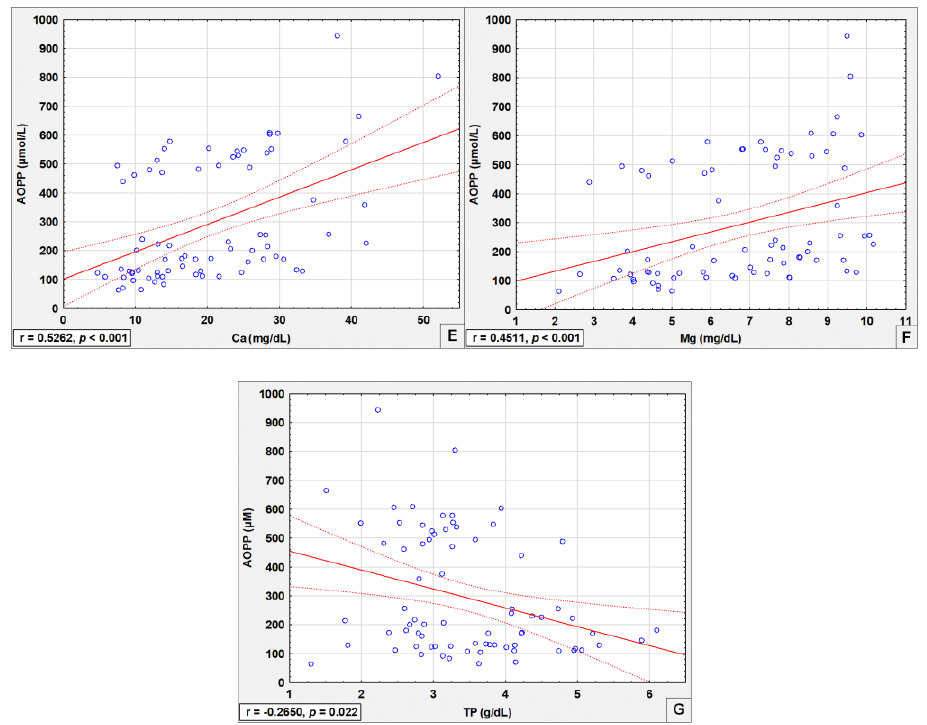
Figure 2. Correlations between concentrations of determined seminal plasma parameters ( A – G ).